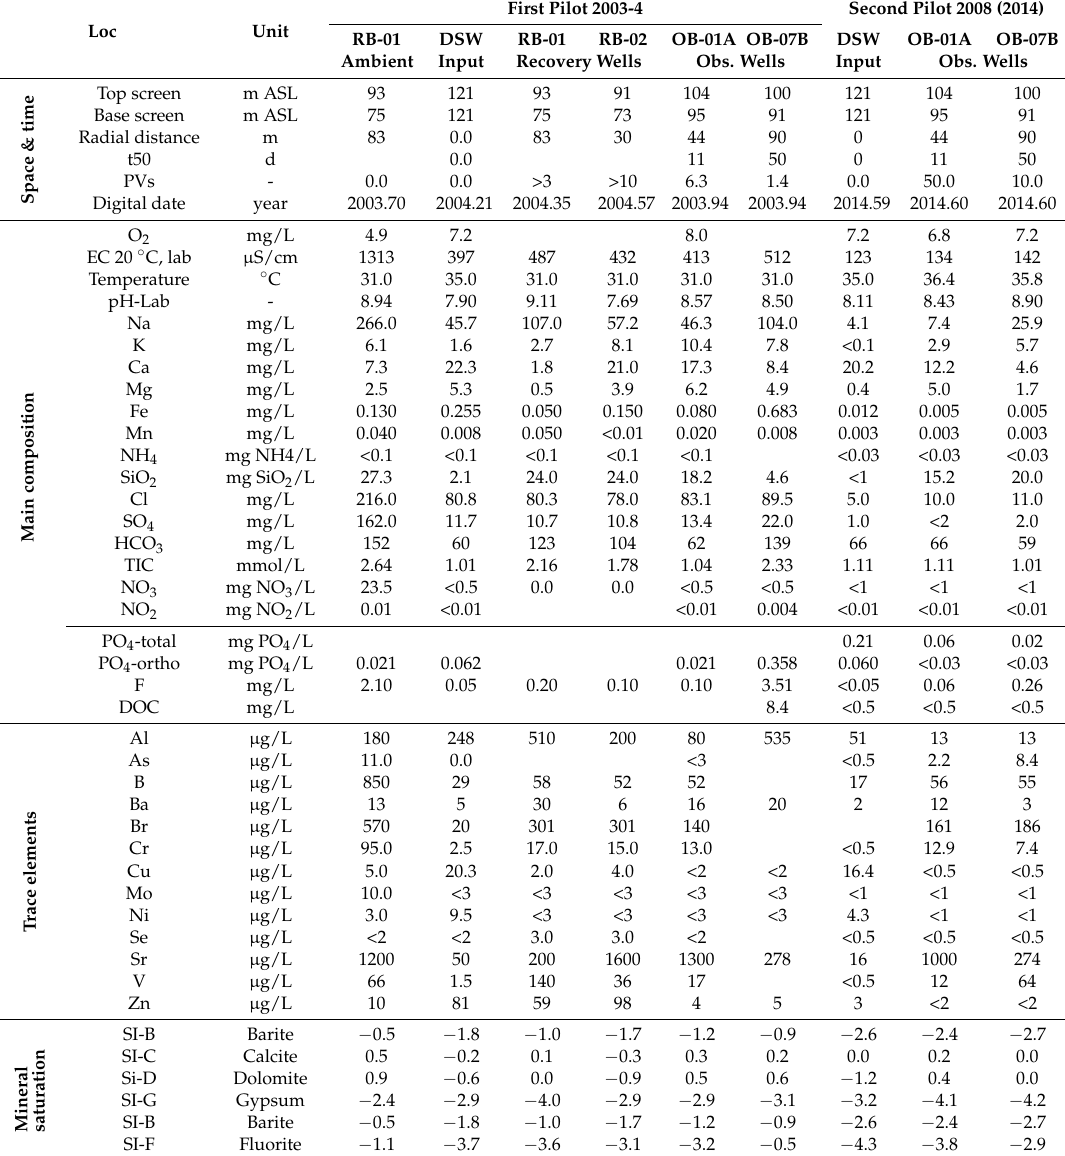
Table 3. Overview of water quality at the pilot basin recharge scheme in 2003–2004 and in August 2014. The samples taken in 2014 refer to a second recharge trial in 2008 at the same pilot plant, and therefore represent DSW after six years of aquifer storage. DSW infiltrated in 2008 (not shown here) deviates only slightly from DSW sampled in